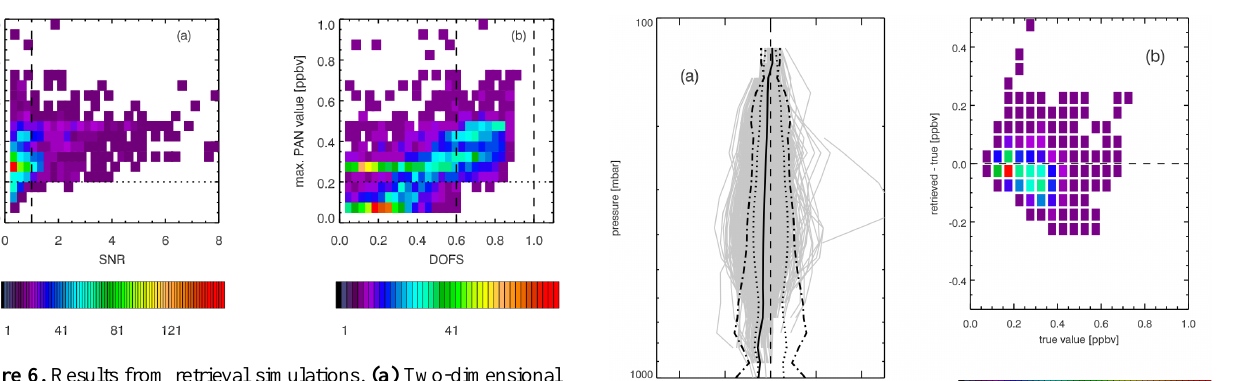
Figure 6. Results from retrieval simulations. (a) Two-dimensional histogram of signal to noise (SNR) against peak PAN VMR. (b) Two-dimensional histogram of DOFS against peak PAN VMR. Color bars show the number of points that fall in each histogram bin.